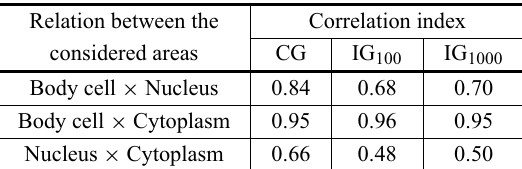
Correlation index among the area of the nucleus, cytoplasm and body cell in the myenteric neurons of the colon of Swiss male mice infected by 100 (IG 100 ) and 1,000 (IG 1000 ) trypomastigotes forms of T. cruzi Y strain and the non-infected